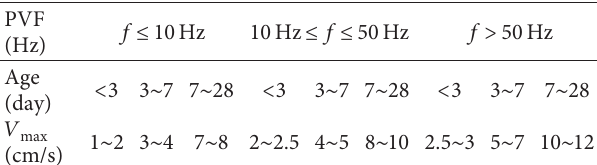
Table 7: Vibration velocity requirement for the newly poured